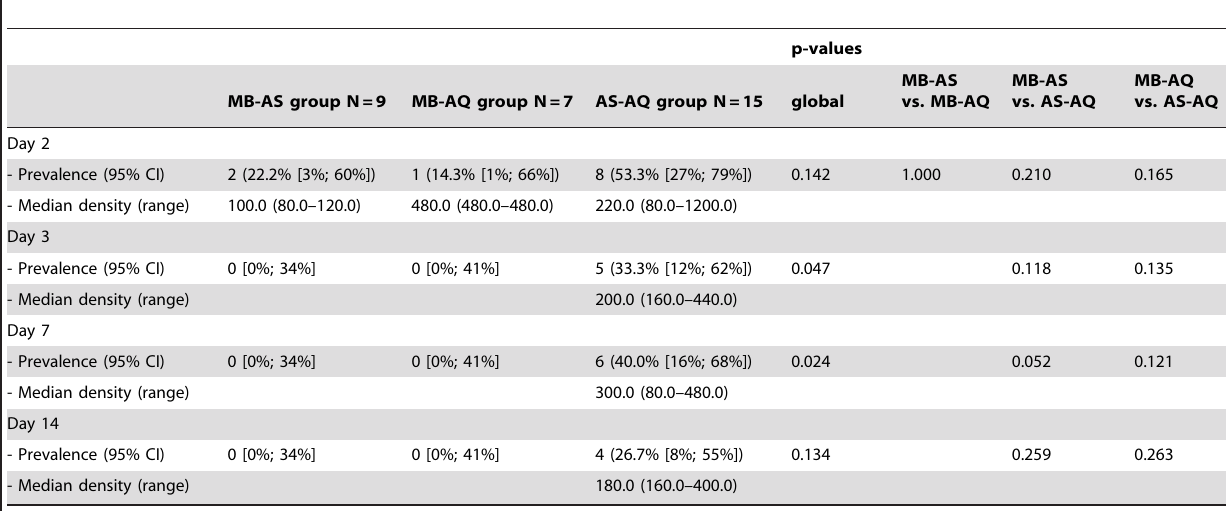
Table 3. P. falciparum gametocytaemia during follow-up in patients with P. falciparum gametocytaemia on day